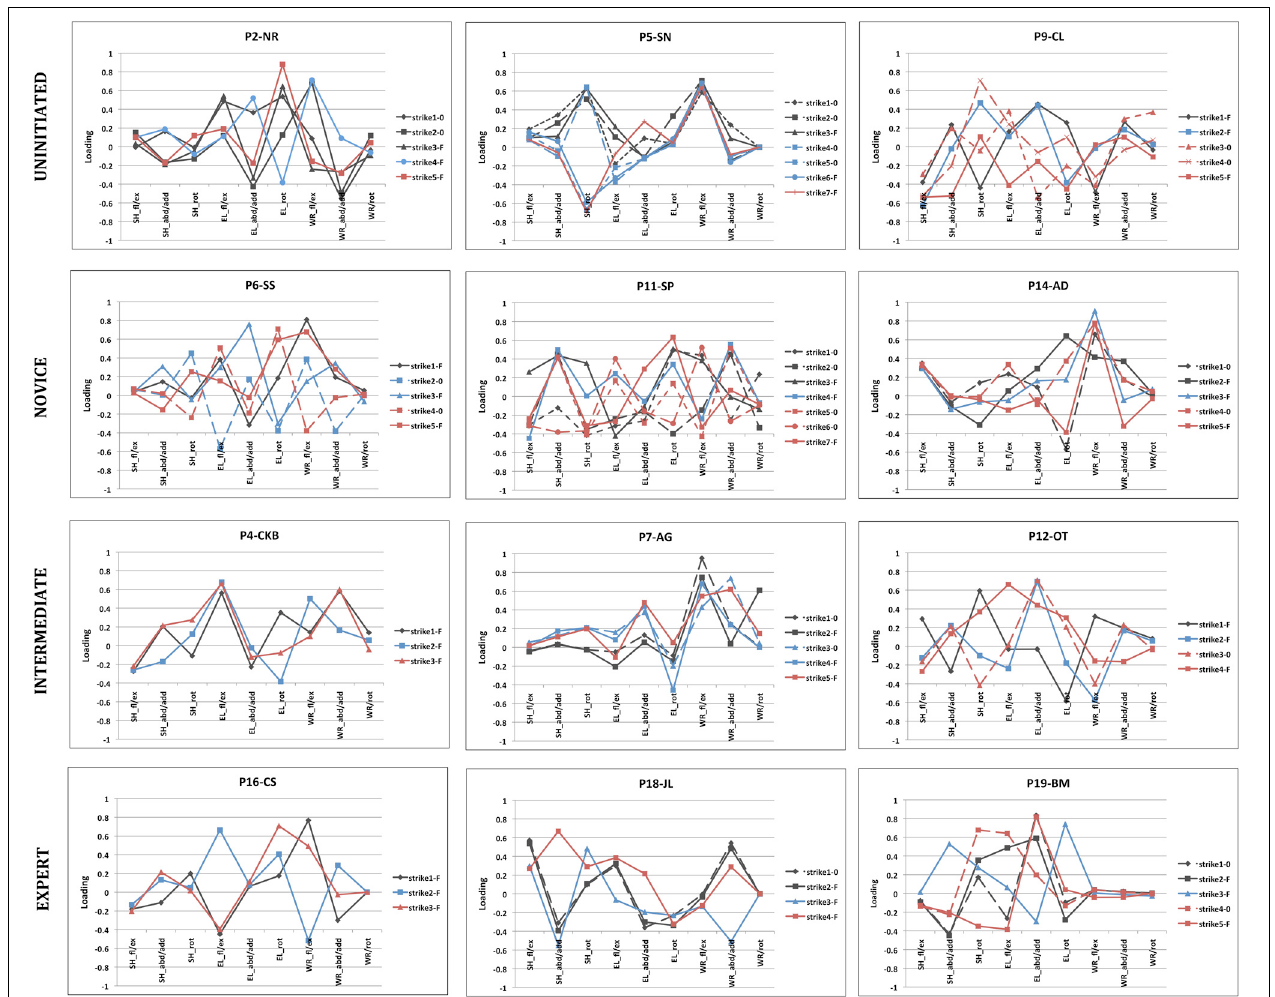
FIGURE 8 | Joint angle contributions to the first principle component. A sample of strikes used in the production of three small flakes with a 600g hammerstone. Three subjects from each skill level group (uninitiated, novice, intermediate, and expert) are provided as examples. Black traces represent